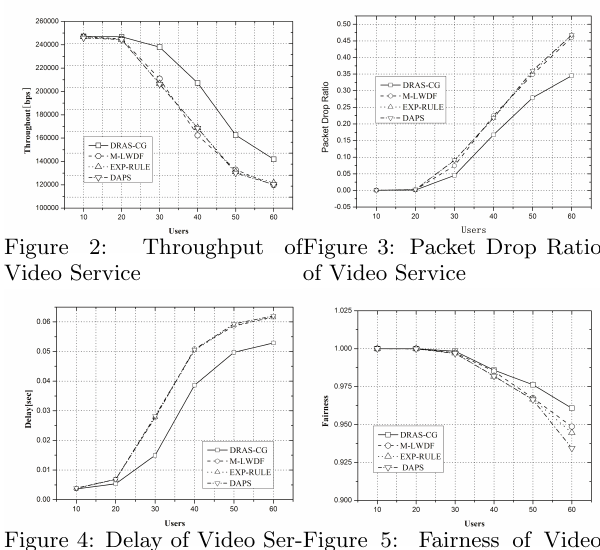
Figure 4: Delay of Video Ser- Figure 5: Fairness of Video